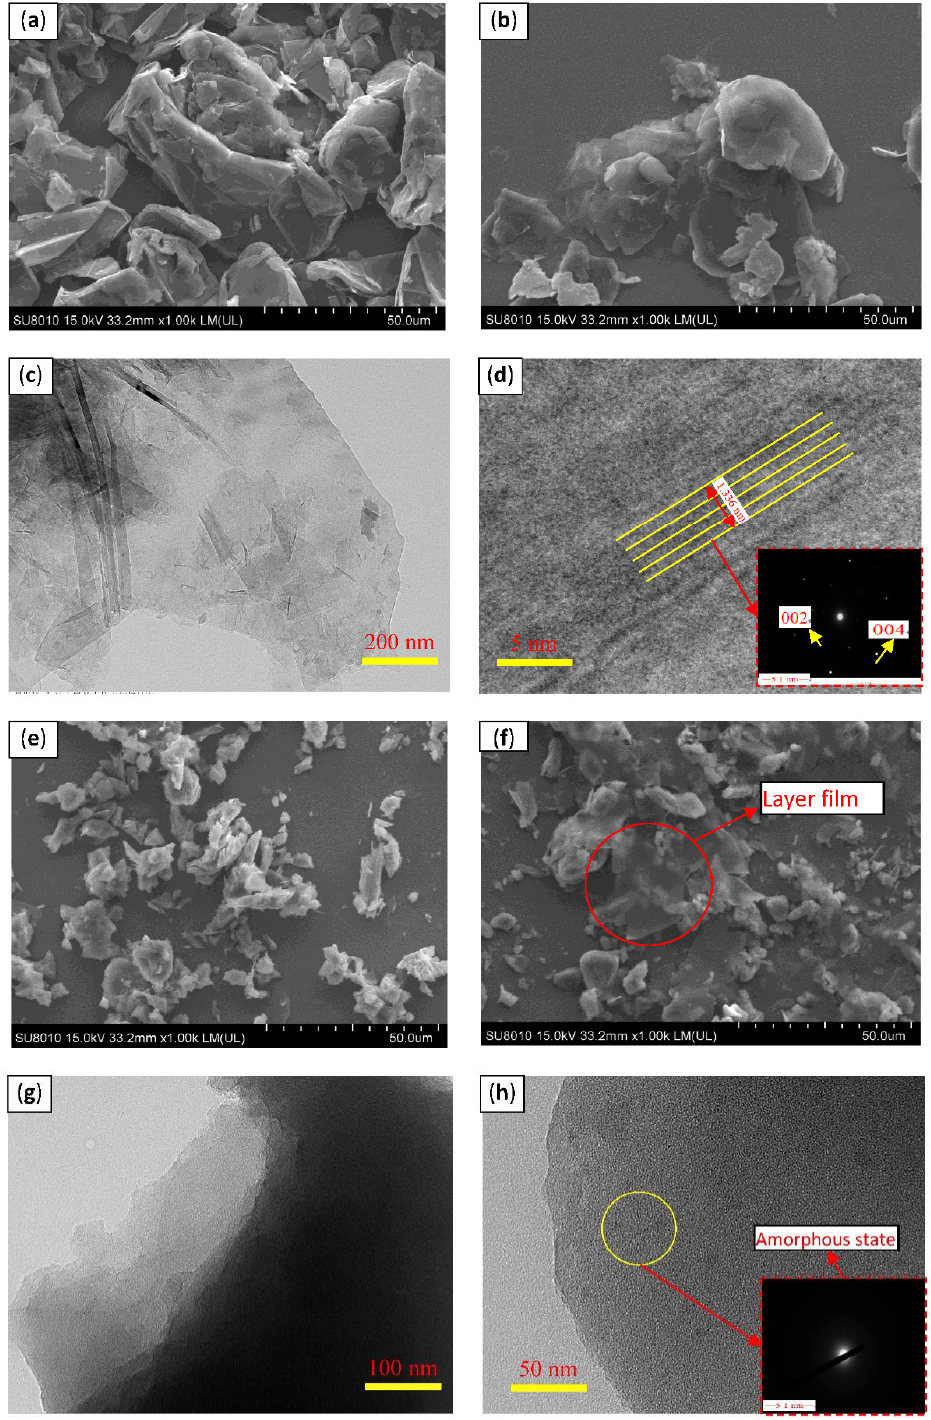
Figure 2. SEM and HRTEM images of different carbon materials. ( a ) SEM image of graphite, ( b ) SEM image of graphene, ( c , d ) HRTEM image of graphene and selected diffraction pattern, ( e ) SEM image of fluorinated graphite, ( f ) SEM image of fluorinated graphene ( g , h ) HRTEM image of fluorinated graphene and selected diffraction pattern.